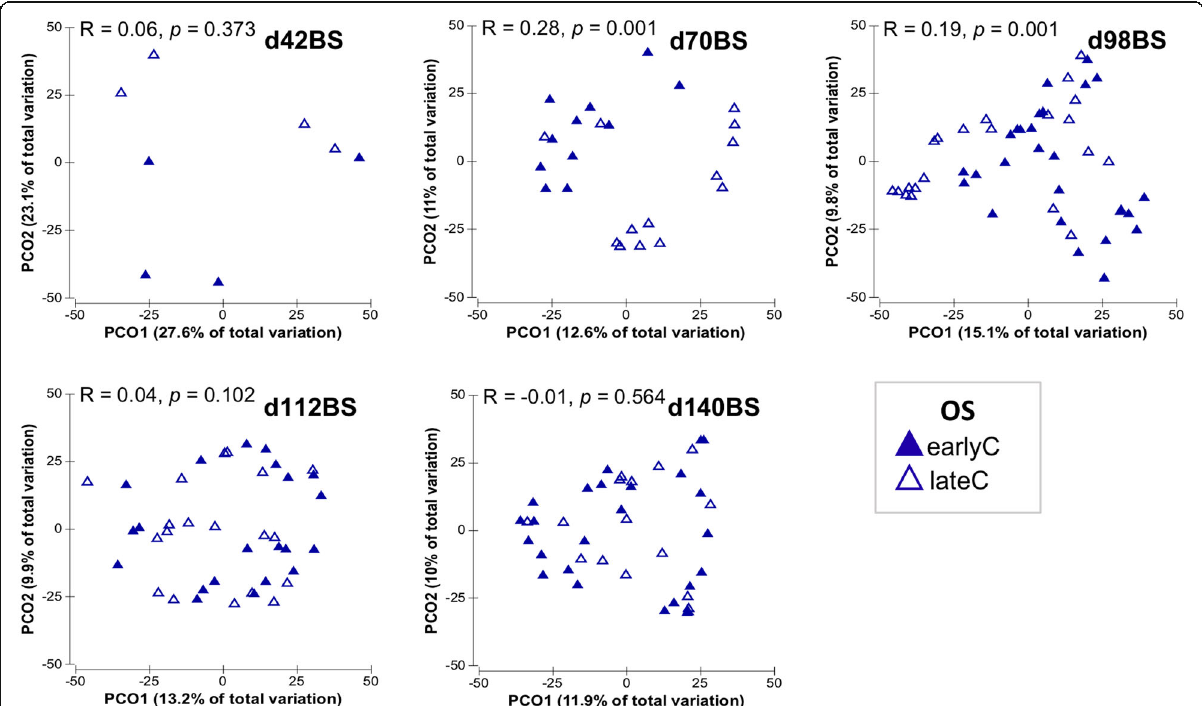
Fig. 6 Principal coordinates analysis plots of OS bacterial communities in BS samples of earlyC and lateC groups. Each triangle represents one